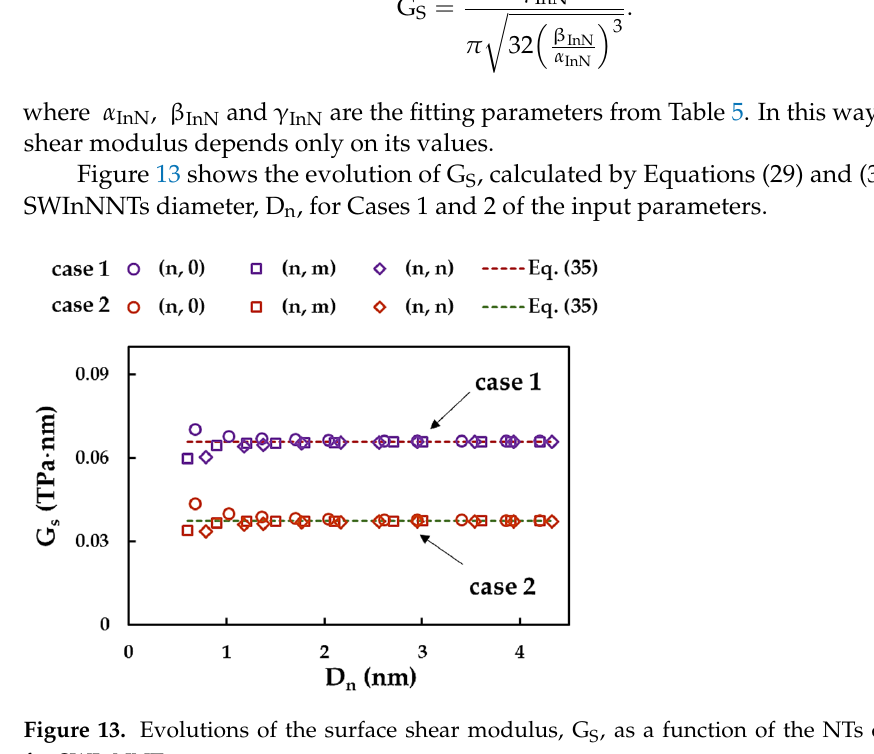
, as a function of the NTs diameter, D S